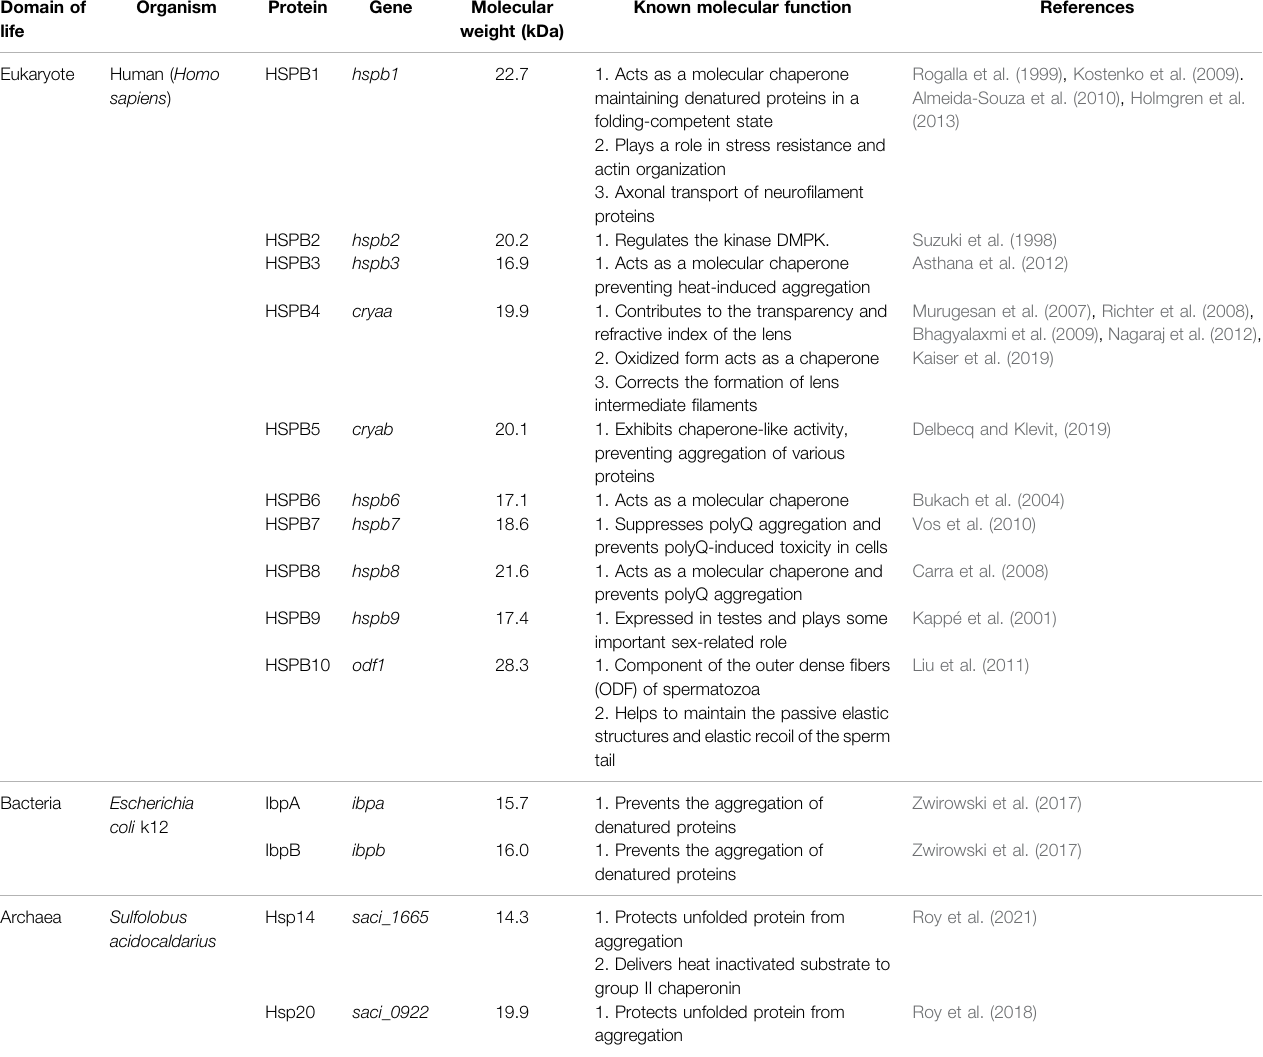
TABLE 1 | A survey of sHsp compositions, molecular weight, and function from all three domains of life. Homo sapiens , Escherichia coli k12, and Sulfolobus acidocaldarius have been presented as representatives from eukaryotes, bacteria, and archaea. Domain of Organism life